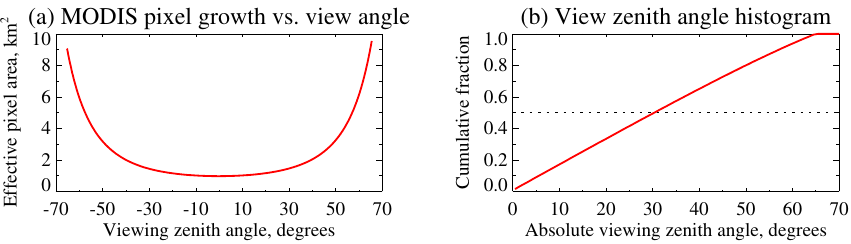
Figure 3. (a) Area of nominal 1km × 1km sensor pixels as a function of VZA, and (b) histogram of absolute VZA. The median is shown with a dashed line. Data for the MODIS granule shown in Fig.